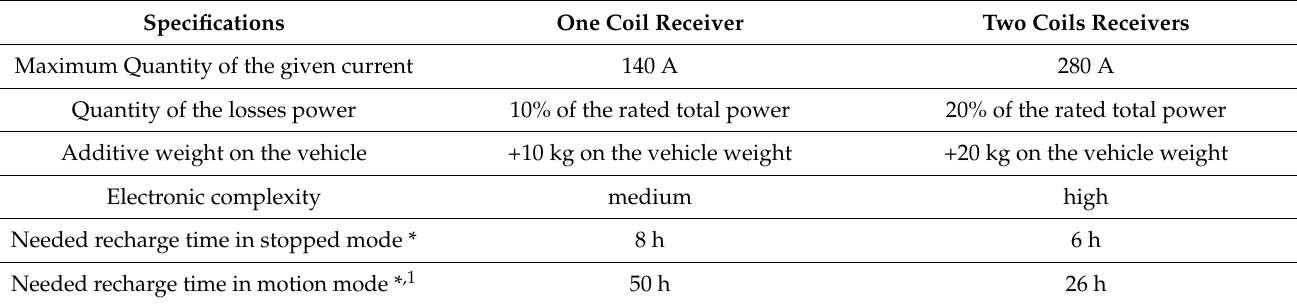
Table 5. Specifications of only one receiver coil and two receiver